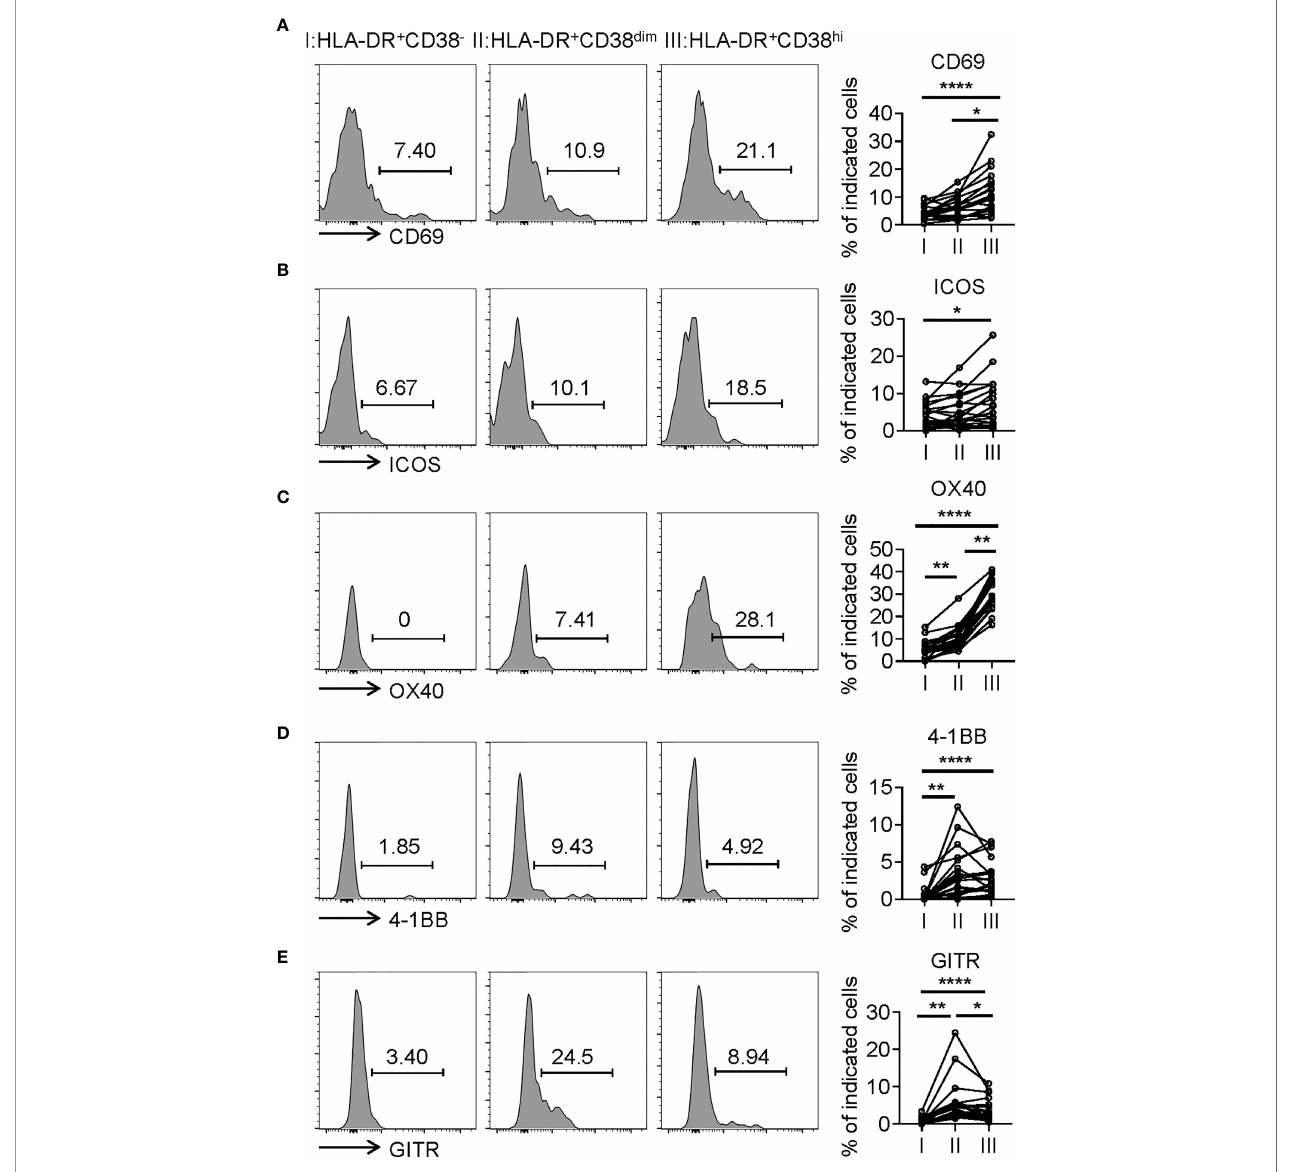
FIGURE 3 | HLA-DR + CD38 hi CD8 + T cells exhibited the phenotype of overactivation. Flow cytometry analysis of expression of CD69 (A), ICOS (B) , OX40 (C) , 4-1BB (D) , and GITR (E) on three CD8 + T populations (I, II, III) from COVID-19 patients (n=20). Representative histograms (left) and plots (right) were shown. P Values were obtained by paired two-tailed Student ’ s t tests and repeated measures by one-way ANOVA test followed by Holm-Sidak ’ s multiple comparisons test. *P < .05, **P < .01, ****P <